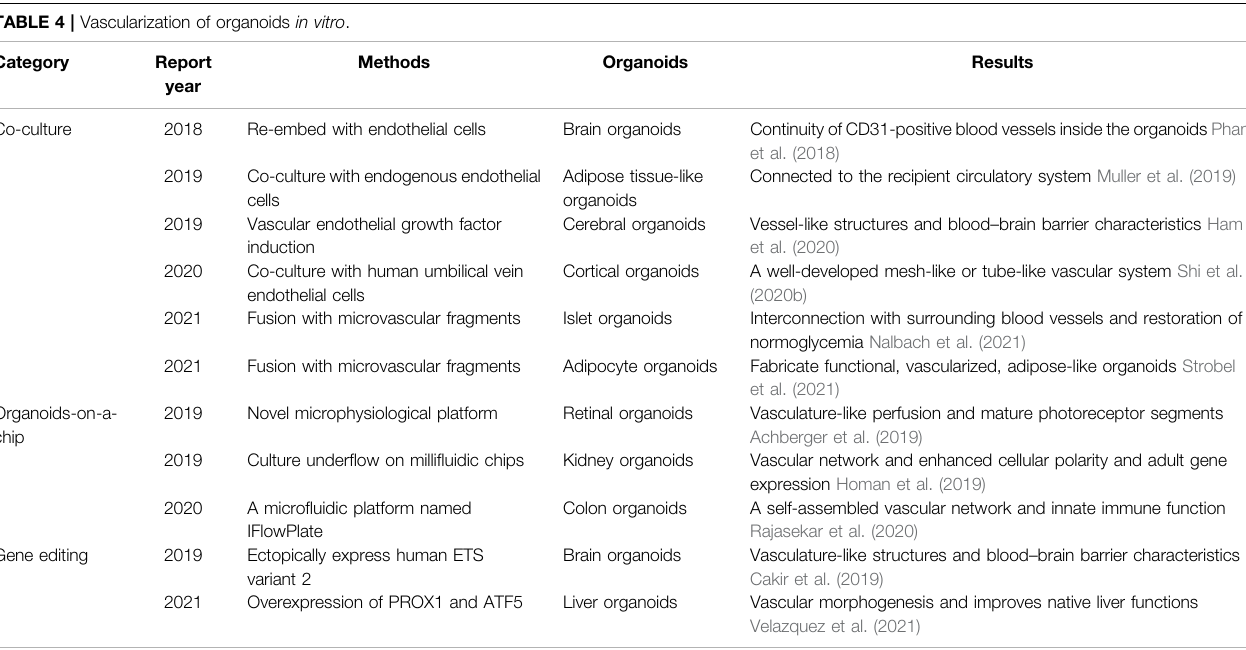
TABLE 4 | Vascularization of organoids in vitro